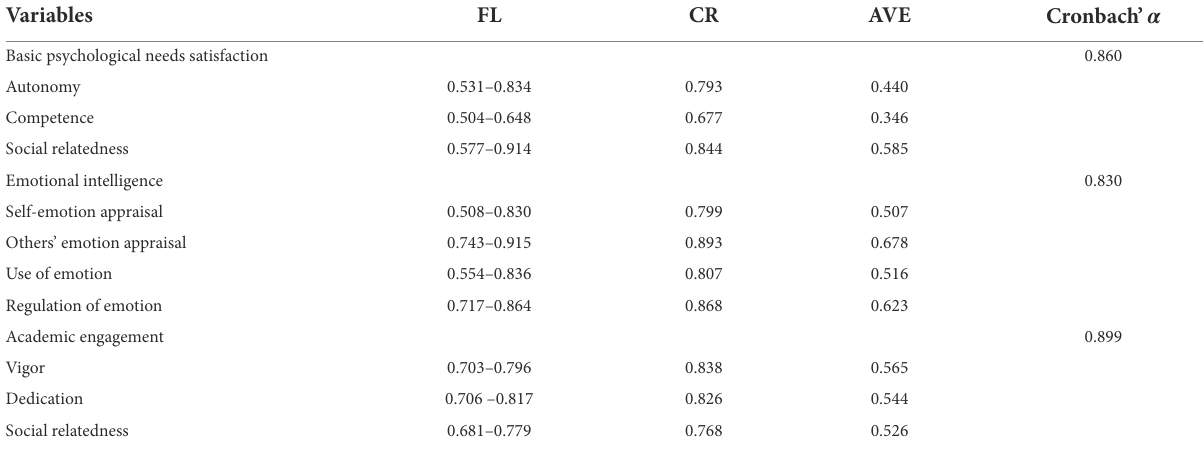
TABLE 1 Results of reliability and validity